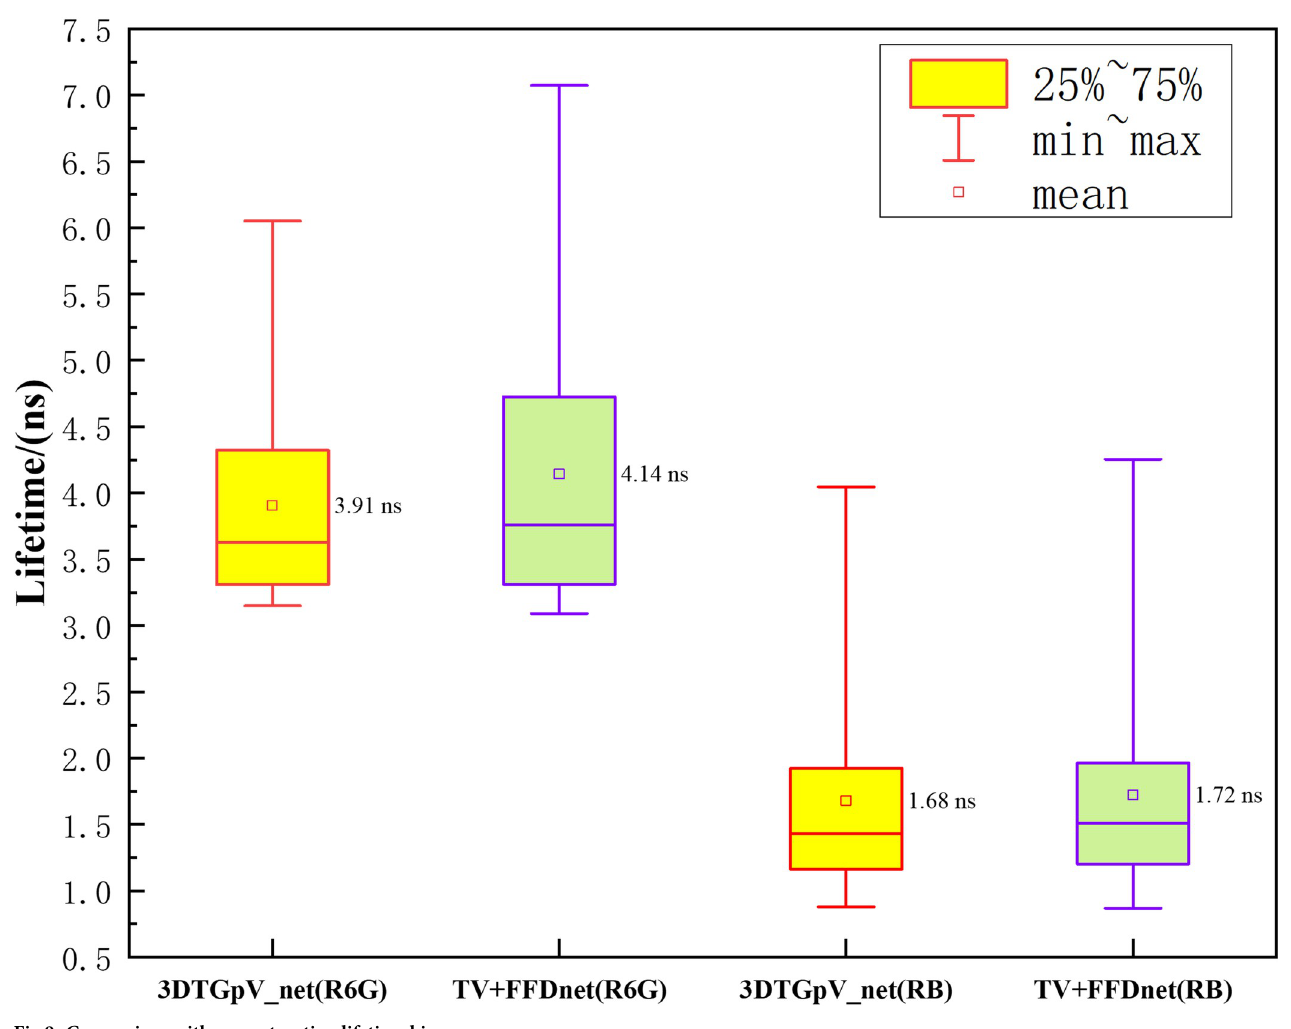
Fig 9. Comparison with reconstruction lifetime